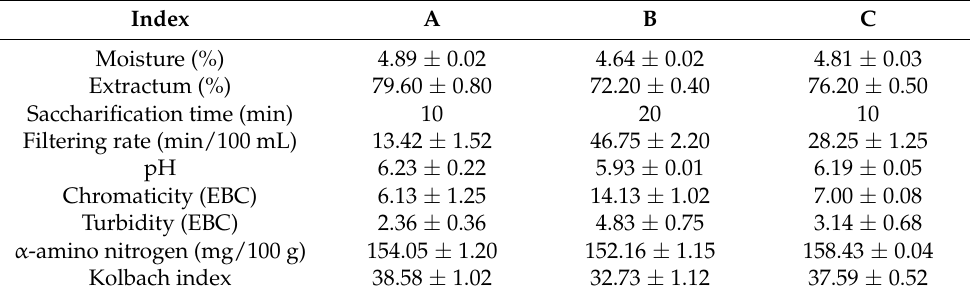
Table 4. Effect of essential oil emulsion on malt